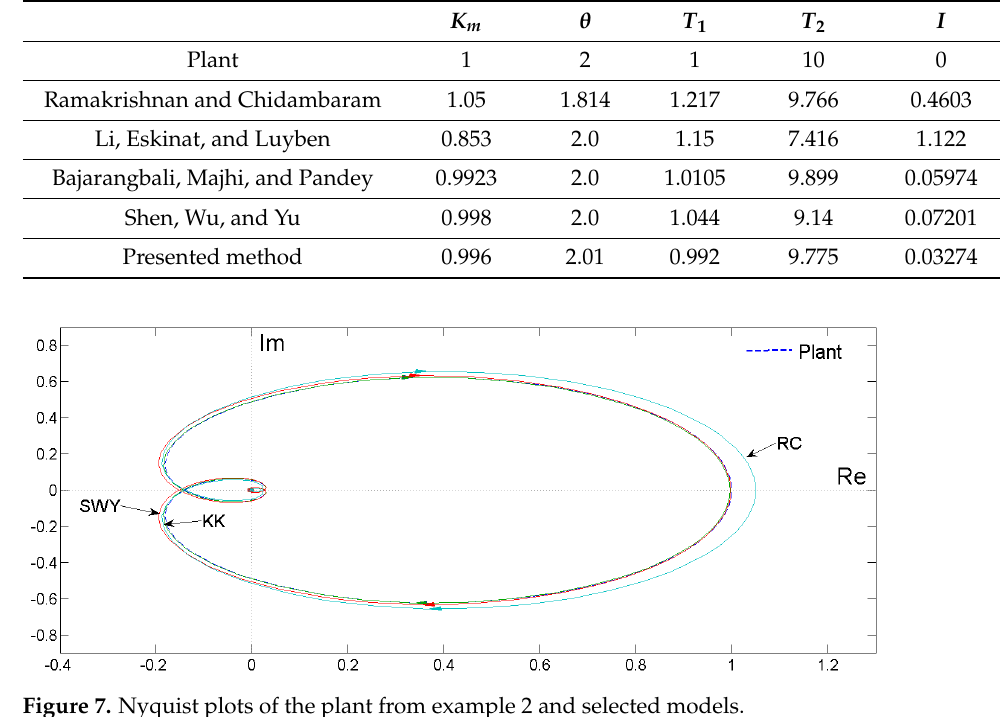
Table 1. Comparison of parameters of the plant and models obtained by considered methods.